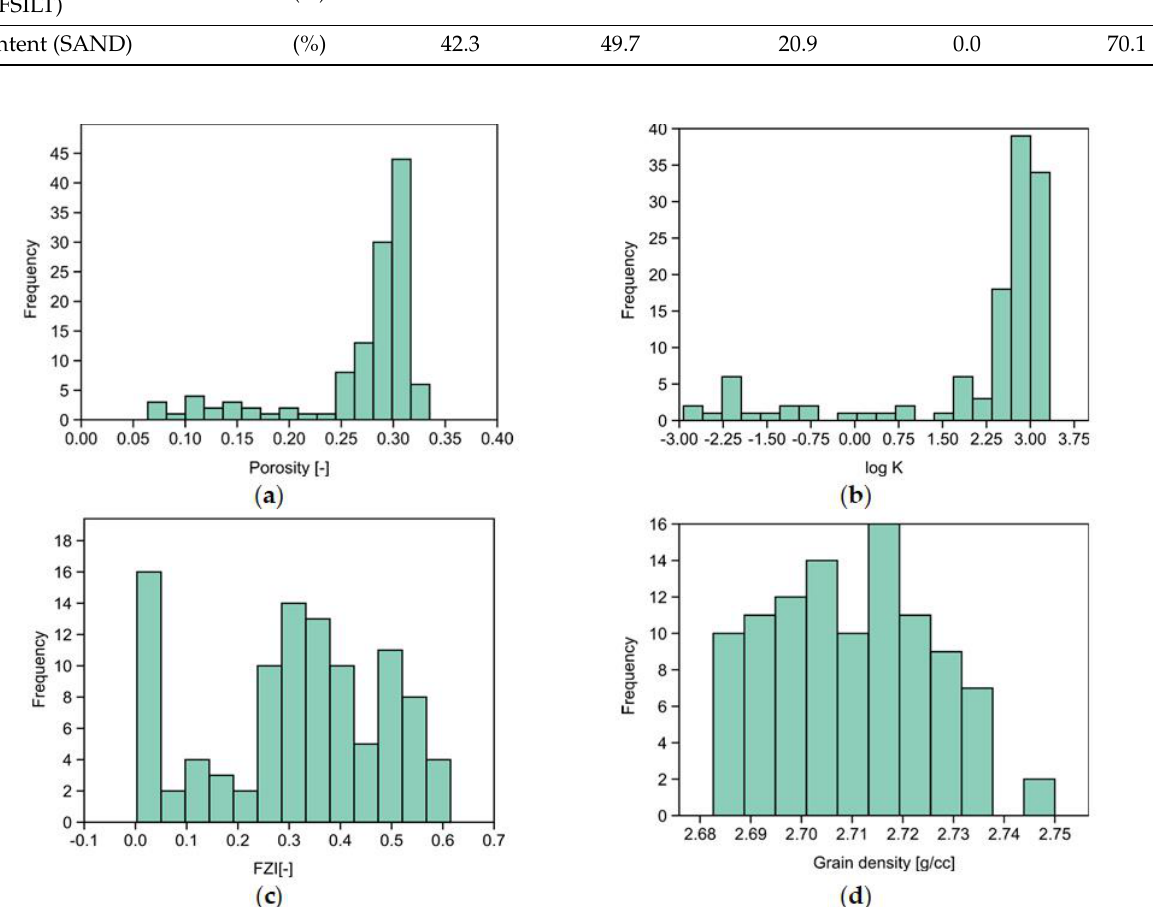
Figure 10. Histograms of ( a ) petrophysical parameters porosity, ( b ) logarithm of permeability (log K), ( c ) Flow Zone Indicator (FZI), and ( d ) grain density. Based on unsupervised clustering of FZI values, samples were classified into four different groups (Figure 11), where group 1 has the lowest FZI and group 4 has the largest one. These groups of samples are interpreted as Petrophysical Rock Types (PRT) that share similar reservoir